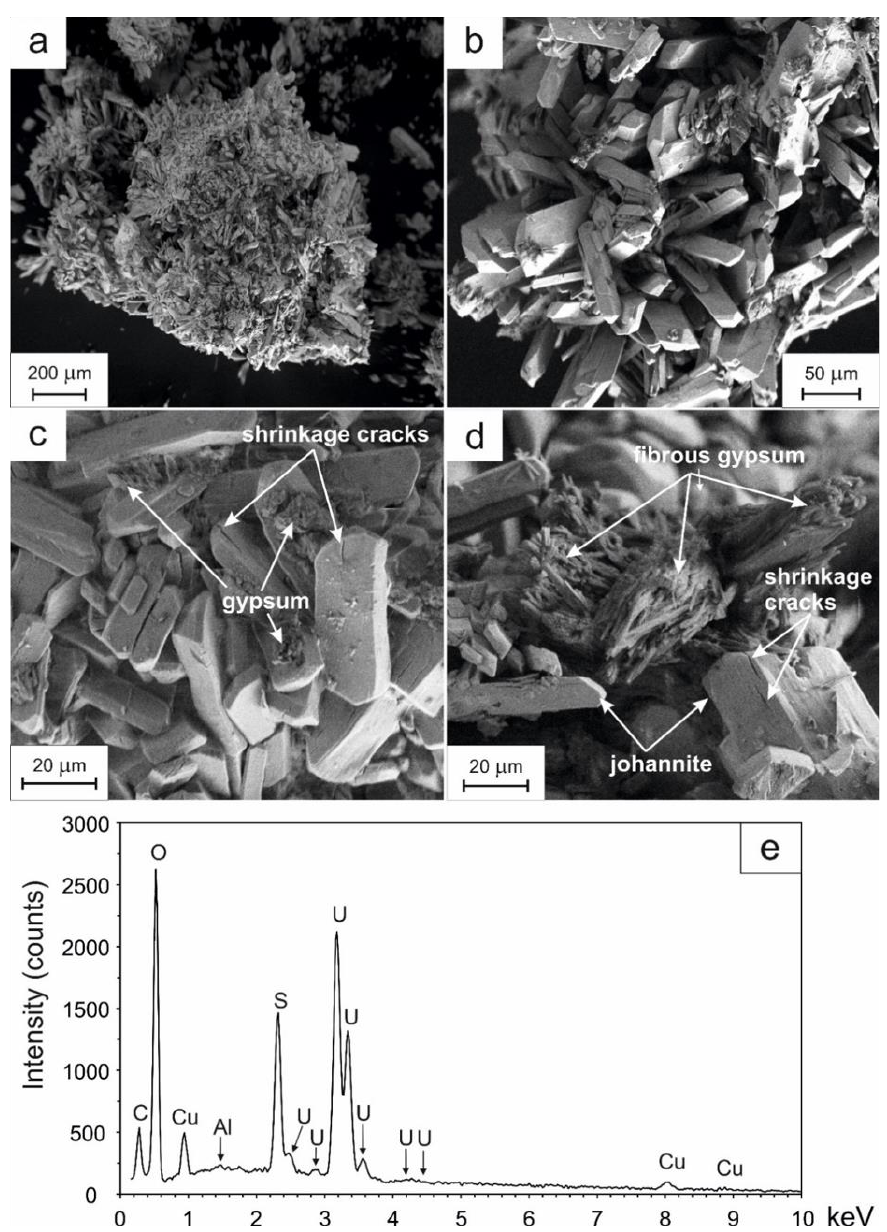
Figure 3. ( a – d ) BSE images of johannite sample NMW 67.154GR.69: ( a ) typical fragment showing a loose aggregate of microcrystalline johannite crystals; ( b ) detailed image showing rosette-like aggregates of radiating bladed prisms of euhedral johannite crystals; ( c ) detailed image showing thick tabular or blocky prismatic morphology of johannite crystals. Some crystals displayed small wedge-shaped cracks, possible due to minor dehydration and shrinkage under the electron beam. Traces of microcrystalline gypsum were present between the johannite crystals; ( d ) aggregates of fine acicular gypsum occurring between crystals of johannite, again displaying small shrinkage cracks; ( e ) EDXA spectrum of johannite with the peaks labelled with their elemental assignment.